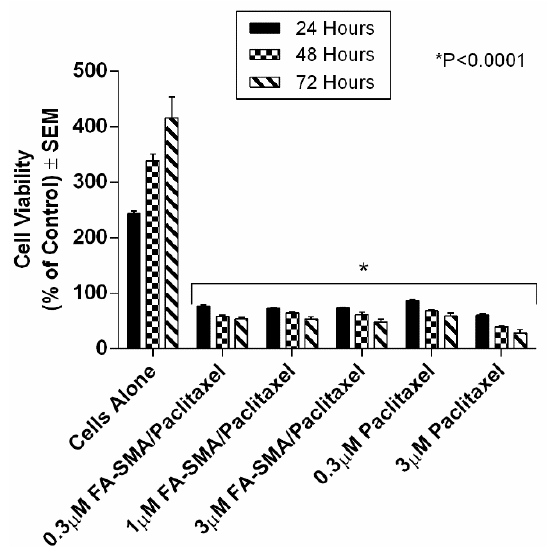
Figure 9. Comparison of the viability of PANC-1 cells at 72 h treated with 0.3 µ M FA-SMA/Paclitaxel, 1.0 µ M FA-DABA-SMA/Paclitaxel, 3.0 µ M FA-SMA/Paclitaxel, 0.3 µ M of Paclitaxel, and 3.0 µ M of Paclitaxel using the WST-1 assay. Paclitaxel was encapsulated at maximum loading capacity in each sample. The data represent the mean ± SEM of n = 5 independent experiments.